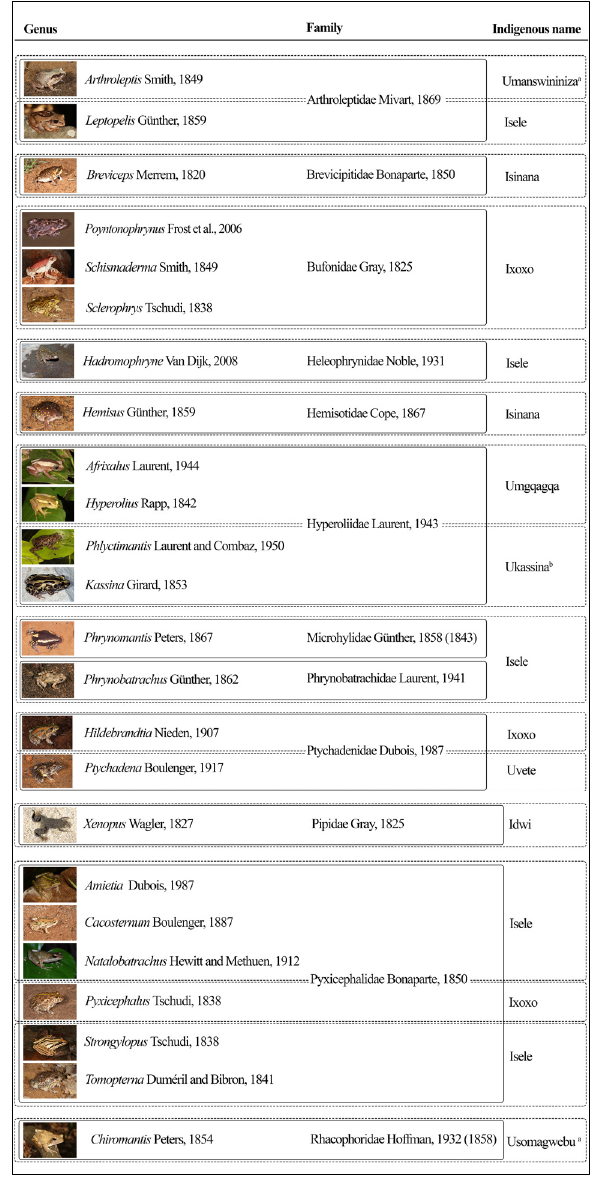
Figure 1: Zululand’s indigenous amphibian taxa and their corresponding scientific taxonomy equivalents.